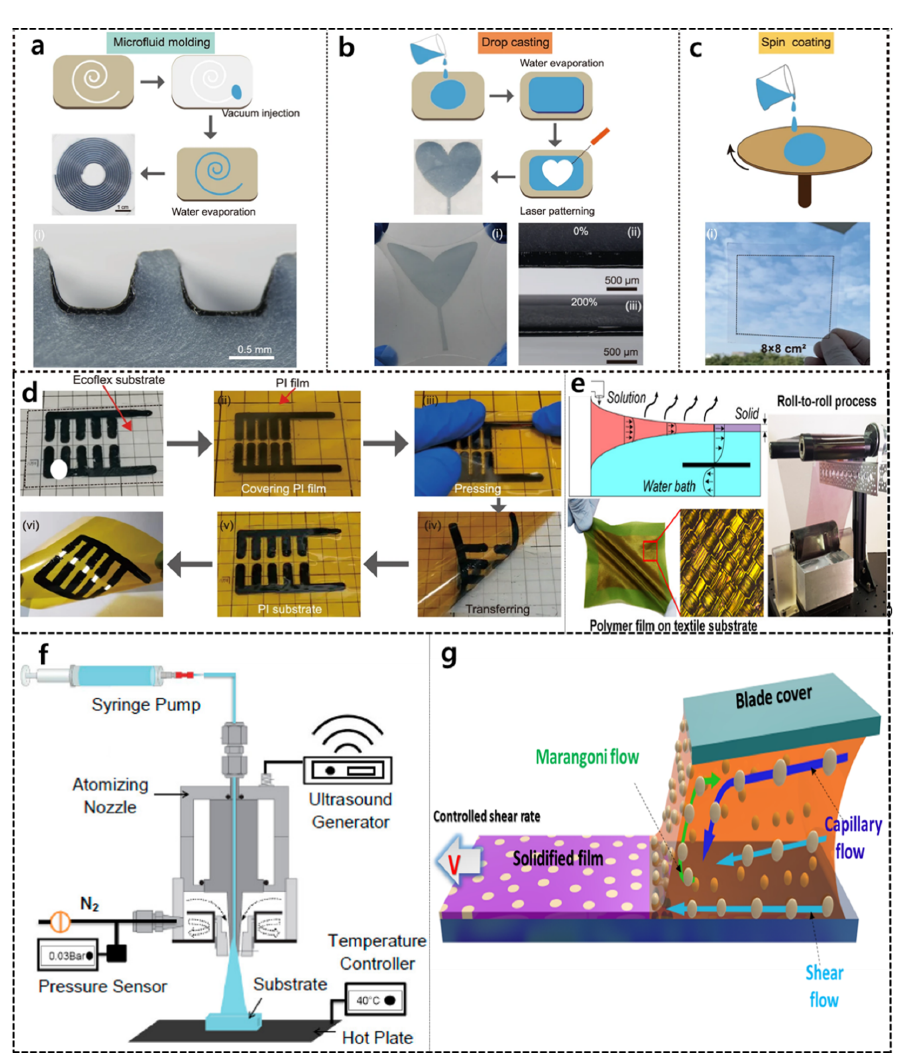
Figure 1. Some solution-based methods for the preparation of CP-based flexible devices: ( a ) Microfluid molding, ( b ) drop casting, ( c ) spin coating, ( d ) combination of drop casting and laser patterning (Reproduced with permission from ref [112]); ( e ) roll-to-roll coating of CP film onto a plastic substrate (Reproduced with permission from ref [121]); ( f ) spray-coating system for CP deposition (Reproduced with permission from ref [124]); ( g ) shear coating system (Reproduced with permission from ref [109]).